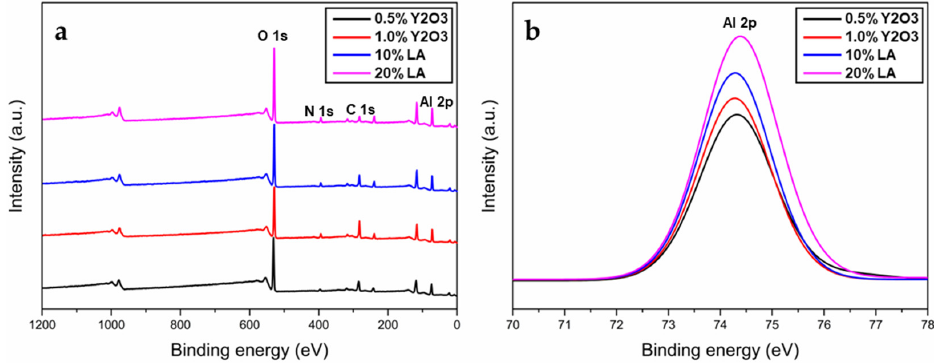
Figure 4. ( a – d ) Photos of the ceramics from AlN–Al 2 O 3 –0.5% Y 2 O 3 , AlN–Al 2 O 3 –1.0% Y 2 O 3 , AlN– Al 2 O 3 –10% LA and AlN–Al 2 O 3 –20% LA, respectively; ( e ) the corresponding transmittance and ( f ) XRD. Table 2. Crystal lattice parameters of the AlON based ceramic samples with different dopants.